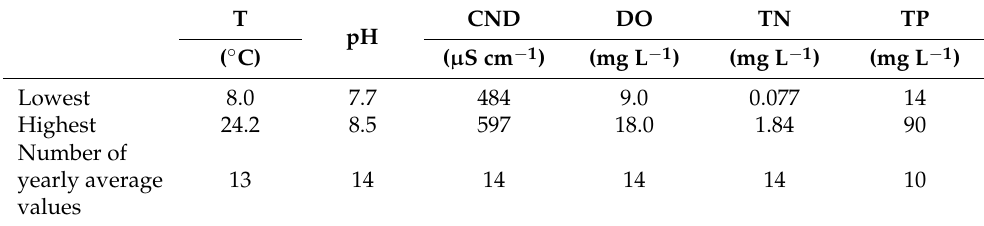
Figure 4. Time series of selected water quality parameters of Lake Vegoritida during the monitoring period 1983–1997: ( a ) water temperature; ( b ) pH; ( c ) CND; ( d ) DO; ( e ) TN; and ( f ) TP (data were provided by HMRDF 2019). Table 1. Lowest and highest yearly average values of the studied water quality